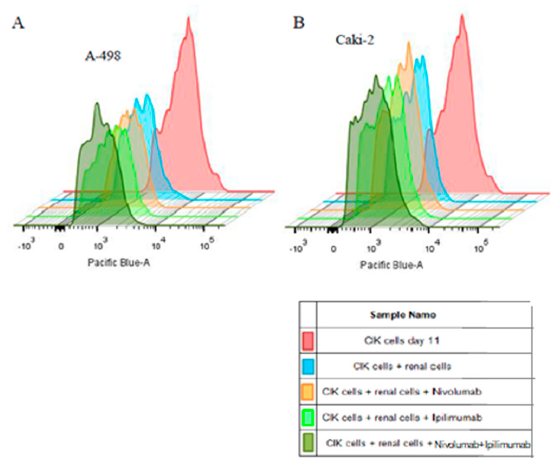
Figure 9. Effects of nivolumab and ipilimumab on proliferation of CIK cells labeled with CellTrace™ violet after 72 h of coculture with renal cells. CIK cells on day 8 were stained with CellTrace™ violet and were administered antibodies for 4 h. Pretreated CIK cells then were cocultured with A-498 or Caki-2 cells. After 72 h of incubation, all cells were harvested and analyzed by flow cytometry. ( A ) Histogram of CIK cells with A-498 coculture. ( B ) Histogram of coculture of CIK cells with Caki-2.